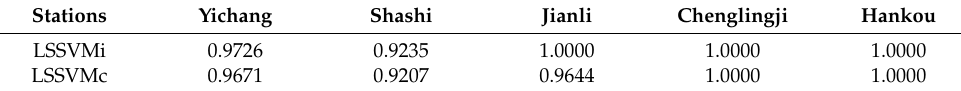
Table 3. Computations of qualified rate R q by using LSSVM i and LSSVM c .